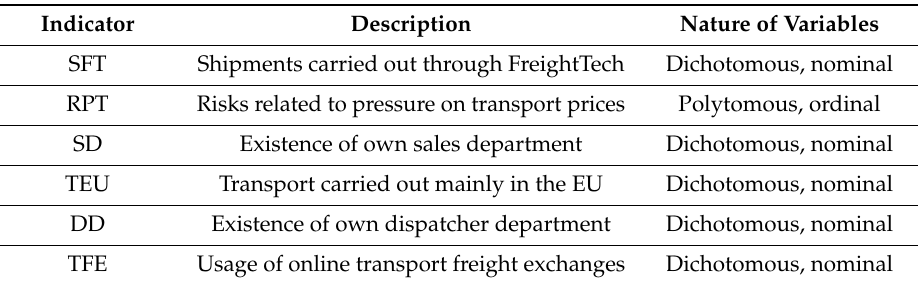
Table 2. The variables of the regression model.